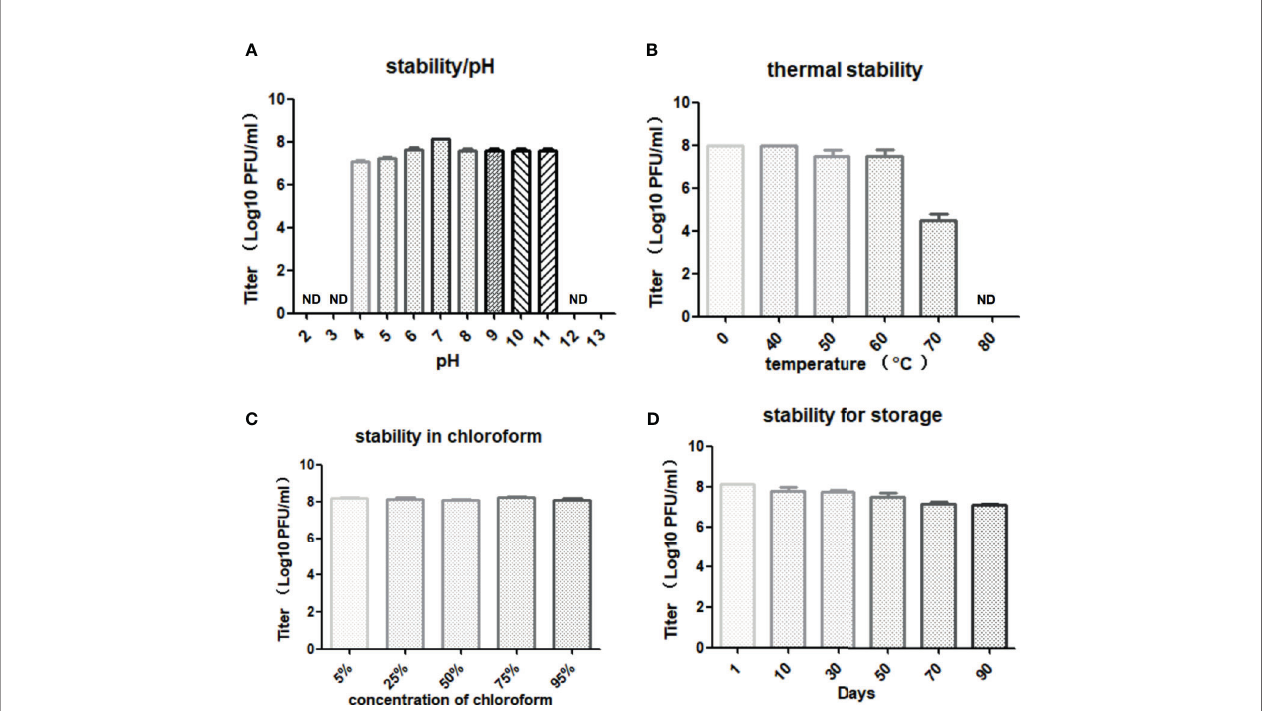
FIGURE 3 | StabilityofLG1. (A) PhageLG1isstableunder pH4~11butsigni fi cantlyinactivatedunderpH4 or abovepH11. (B) LG1isinactivatedby80°Ctreatment. (C) LG1 is non-sensitiveto chloroform treatment. (D) LG1isstablefor3 monthswithoutasigni fi cantdecreaseoftiter whenstoredat4°C.ND, not